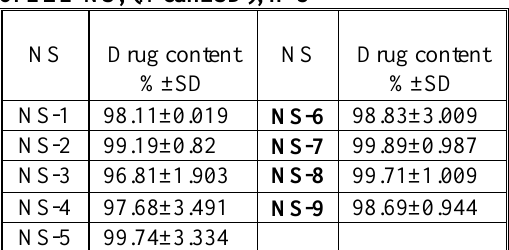
Table 7. Drug Content Percent Measurement of LZL-NS; (Mean±SD); n=3